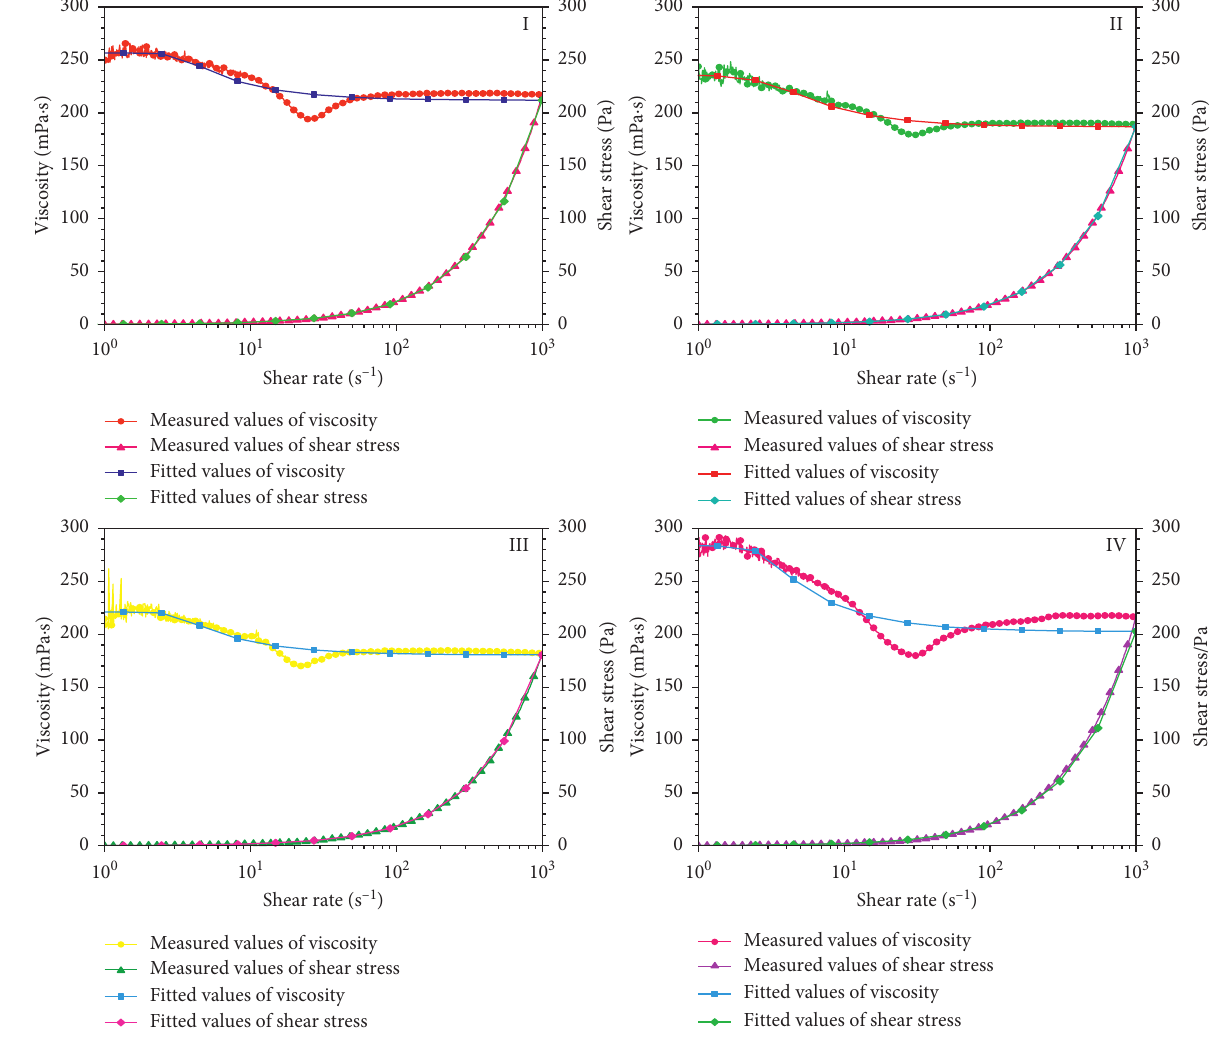
Figure 6: Viscosity measurement curve and fitting curve. Table 5: Viscosity value of component B. Group of